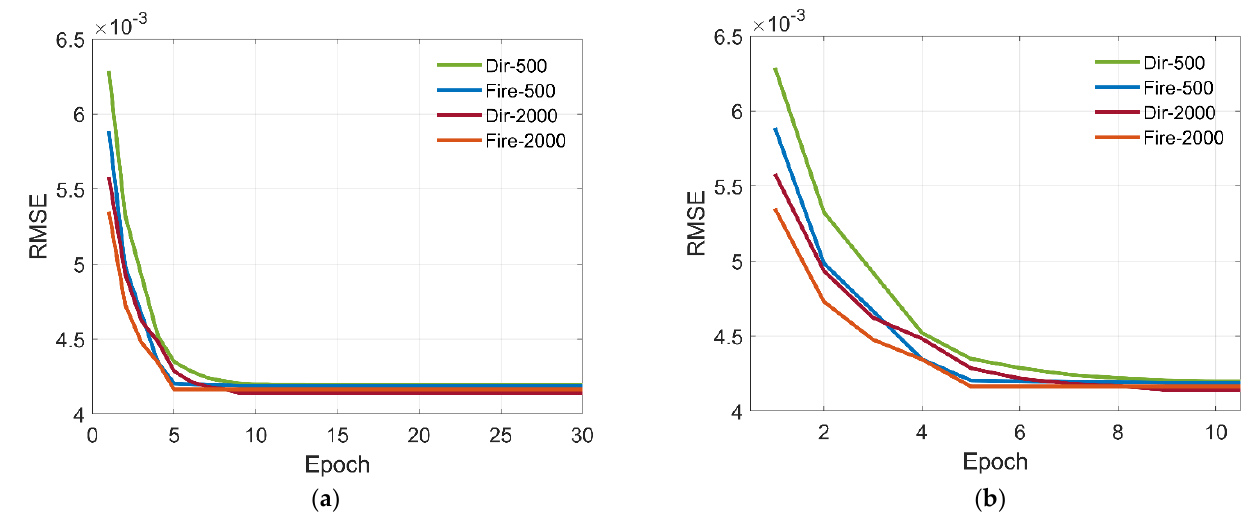
Figure 13. Evolution of the RMSE of different networks versus epoch. ( a ) Original image. ( b ) Local amplification.